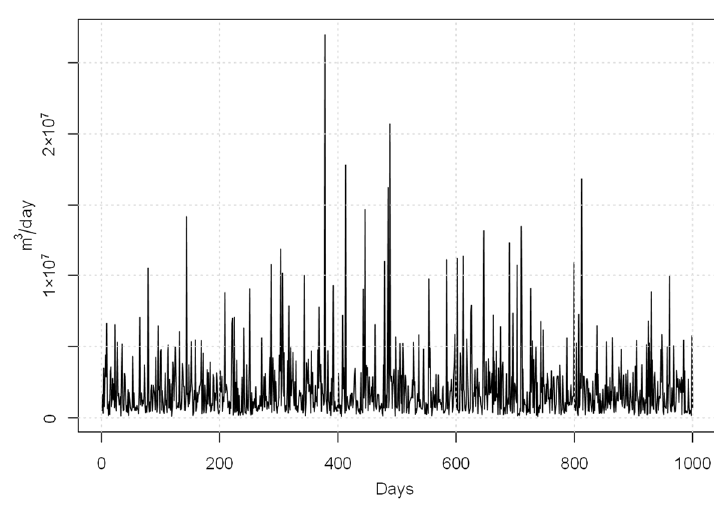
Figure 6. Gas flow rate time series at one of the gas consumption points.